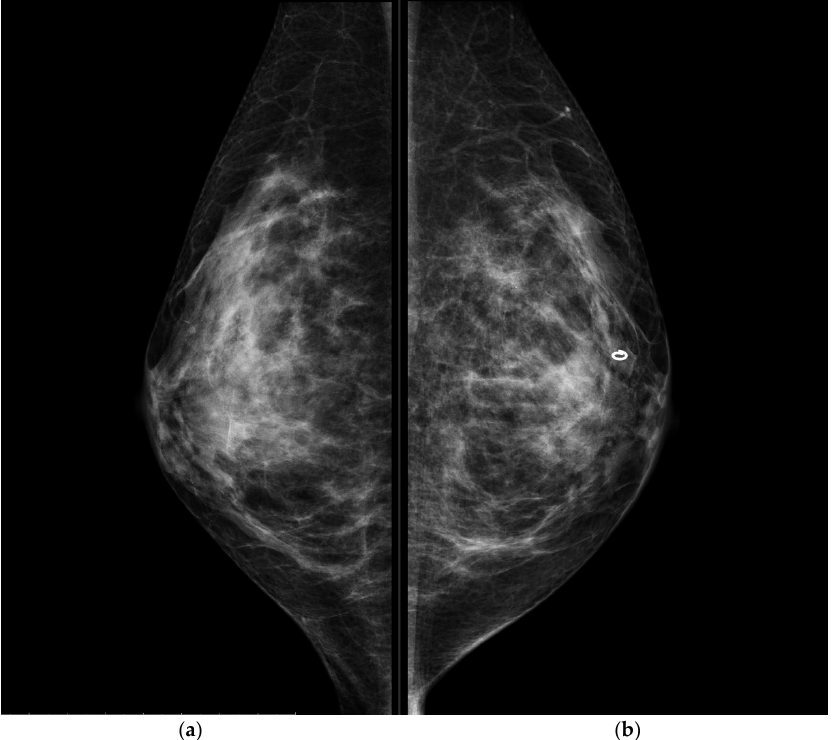
Figure 3. Conventional MLO projections of the right breast ( a ) and left breast ( b ). The circular-shape marker released after US-guided biopsy was present in the retro-areolar left breast. MLO projections, as CC, showed no mammographic altera- tions.